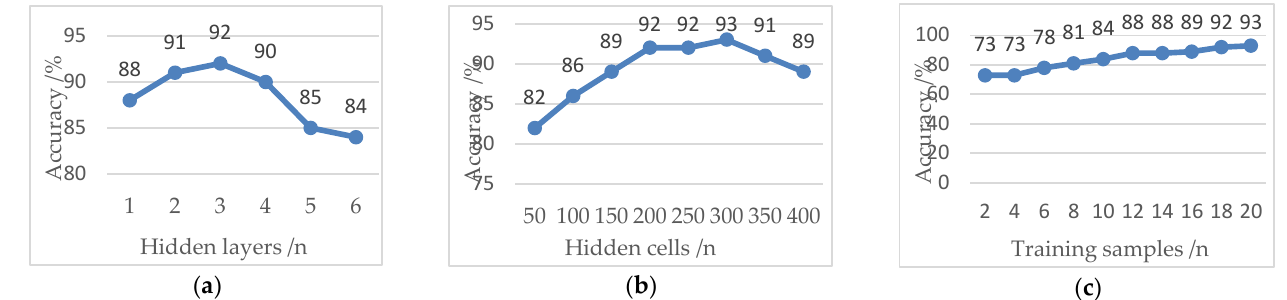
Figure 12. Accuracy of the deep belief network (DBN) system: ( a ) relationship between hidden layers and accuracy; ( b ) relationship between hidden cells and accuracy; and ( c ) relationship between training samples and accuracy.